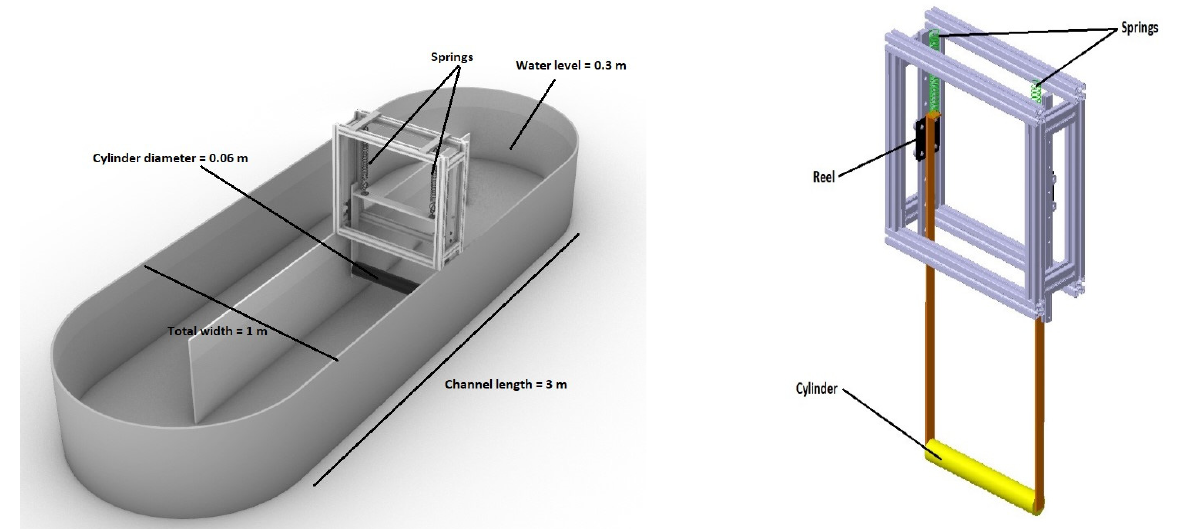
Figure 4. General view of VIV system implemented to RWP channel ( left ). Details of VIV system components ( right ).